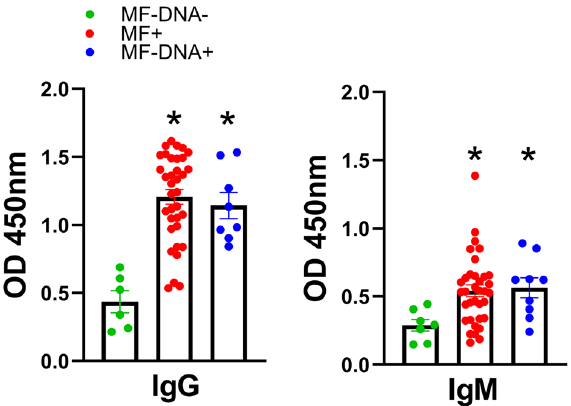
Figure 1. D. repens somatic antigen (DrSA) ELISA enables to detect infections in microfilaremic and amicrofilaremic dogs. The IgG and IgM levels were analyzed in dogs sera against DrSA. Plates were coated with 2.5 µg/ml of DrSA in carbonate buffer. The blocking step was performed with PBS containing 5% skimmed milk. Dog sera and secondary anti-dog IgG/IgM-HRP antibodies were used in 1:1,600 and 1:50,000 dilution, respectively. The statistically significant differences between examined groups are marked with an asterisk: * p <